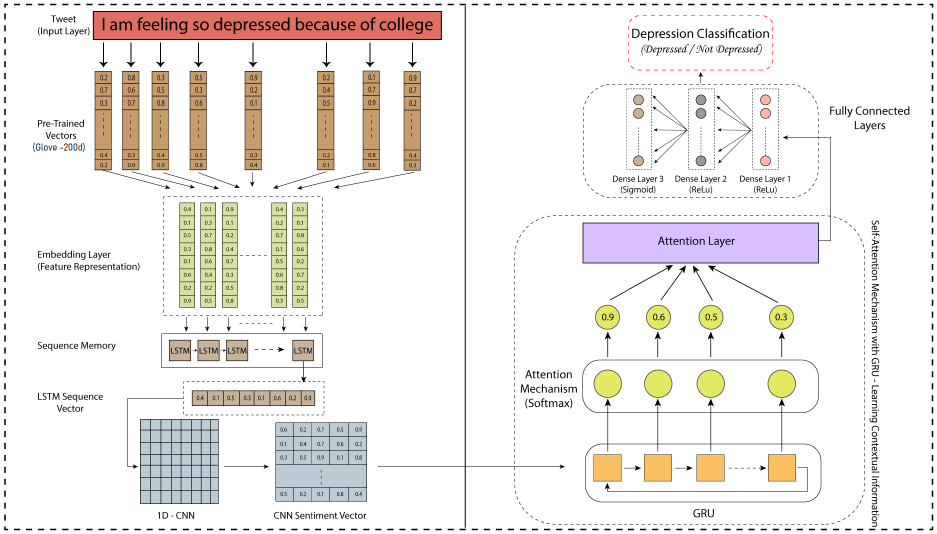
Figure 7. An example tweet processed through our proposed